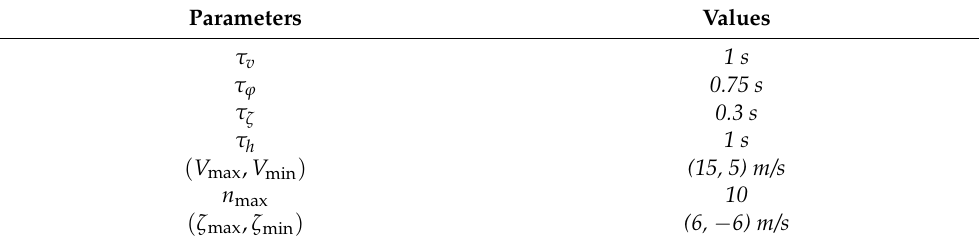
Table 6. Parameter setting of UAVs.